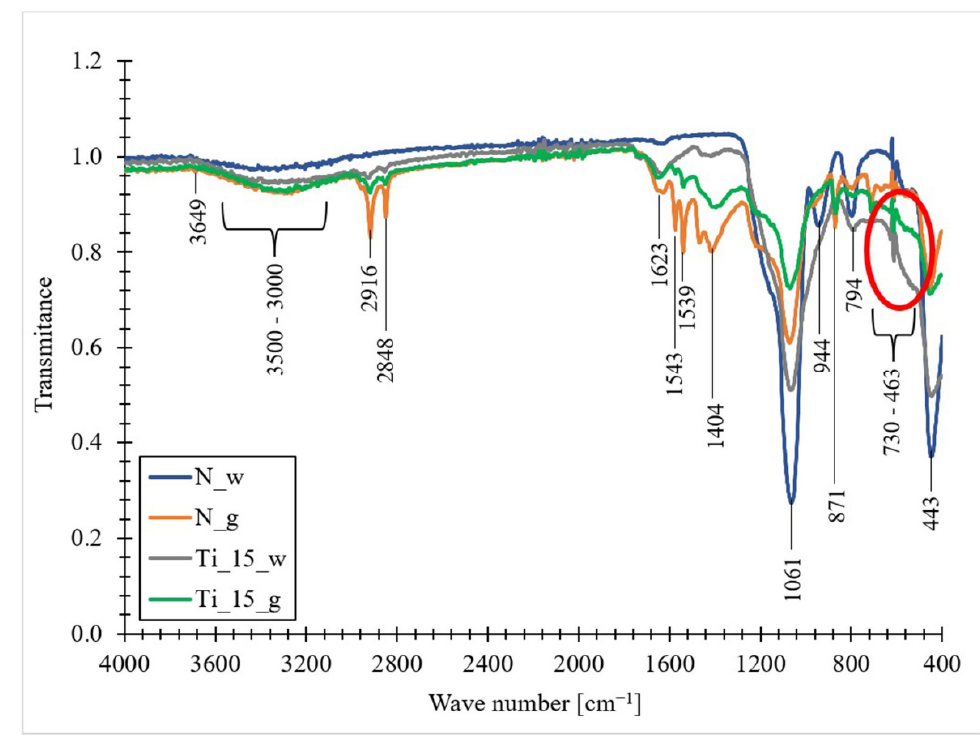
Figure 9. FTIR-ATR spectra of undoped biomass, titanium-doped biomass, pure diatomaceous biosilica and titanium-doped diatomaceous biosilica (N_g-undoped biomass; N_w-pure diatomaceous biosilica; Ti_15_g-the biomass doped with titanium ions with a concentration of 15 mg Ti/L; Ti_15_w-the biosilica doped with titanium ions with a concentration of 15 mg Ti/L).